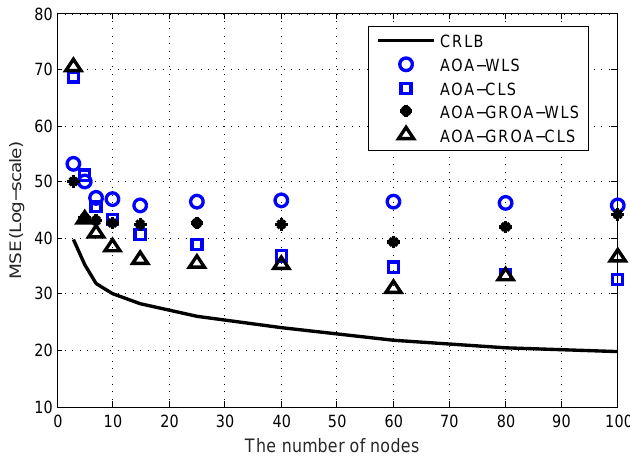
Figure 7. Average MSE results of AOA-only WLS, AOA-only CLS, AOA-GROA WLS and AOA-GROA CLS methods with respect to various number of nodes, σ AOA = 0.05 radian, σ GROA = 3 × 10 − 3 and σ s = 10 − 2